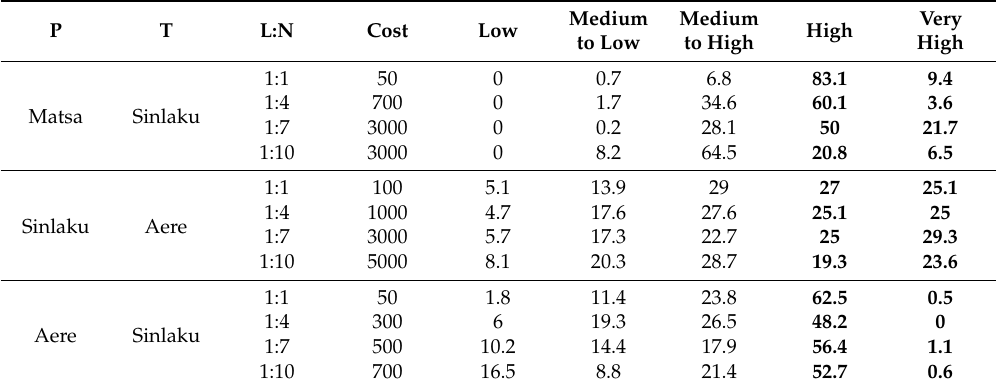
Table 6. Landslide susceptibility distributions (Unit: %) of the event-based occurrence samples on the basis of RF algorithm with cost-sensitive